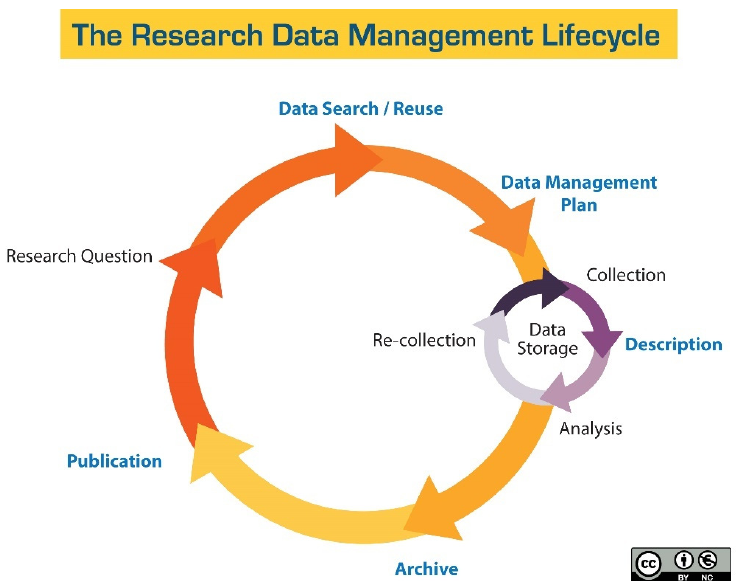
Figure 5. Data life cycle (known as DLM). Source: Google Images Creative Commons License.